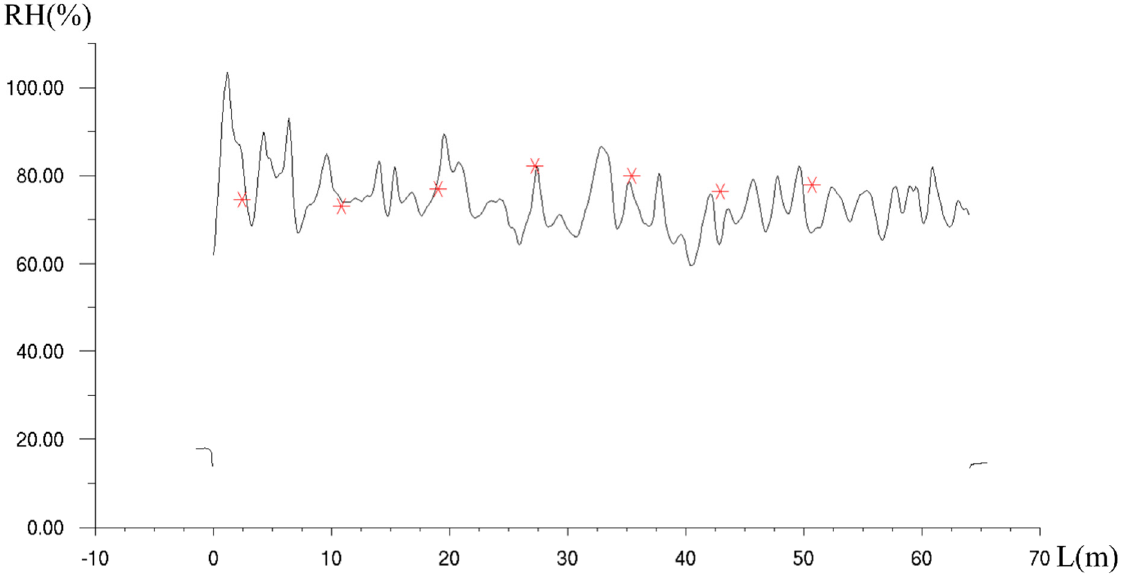
Figure 5. Measured (*) and simulated (---) relative humidity along the greenhouse length (from SW to NE) at the height of 1.34 m in the middle of the greenhouse width (x = 4.3 m).